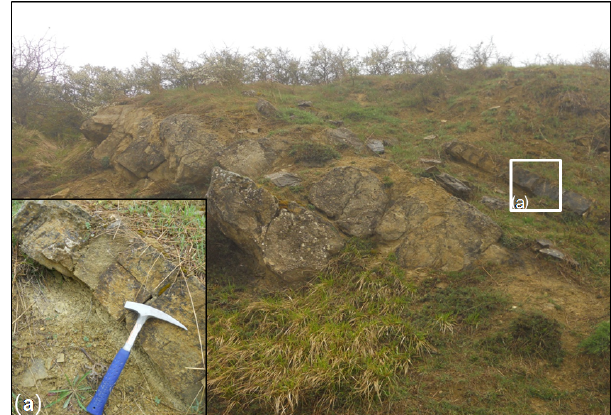
Figure 5. Outcrop of the Gorgoglione Flysch pelitic-arenaceous se- quence at the San Vito Pass. Grey or yellowish sandstones and grey or brown silty marls and silty clays are interbedded. In the zoom box (a) the very sharp contact between sandstones and the underly- ing pelitic level is